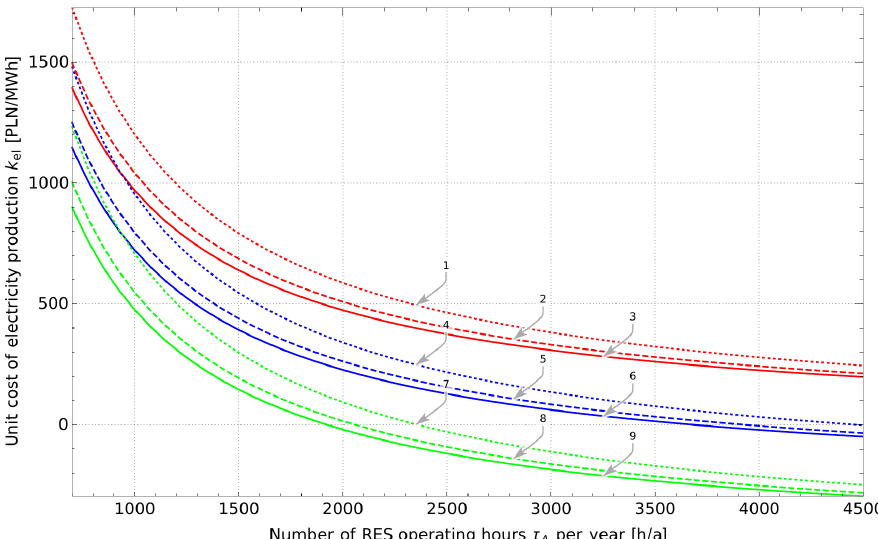
Figure 5. Unit cost of electricity production k el as a function of time τ A for τ 1 = 0, 5 τ 1max